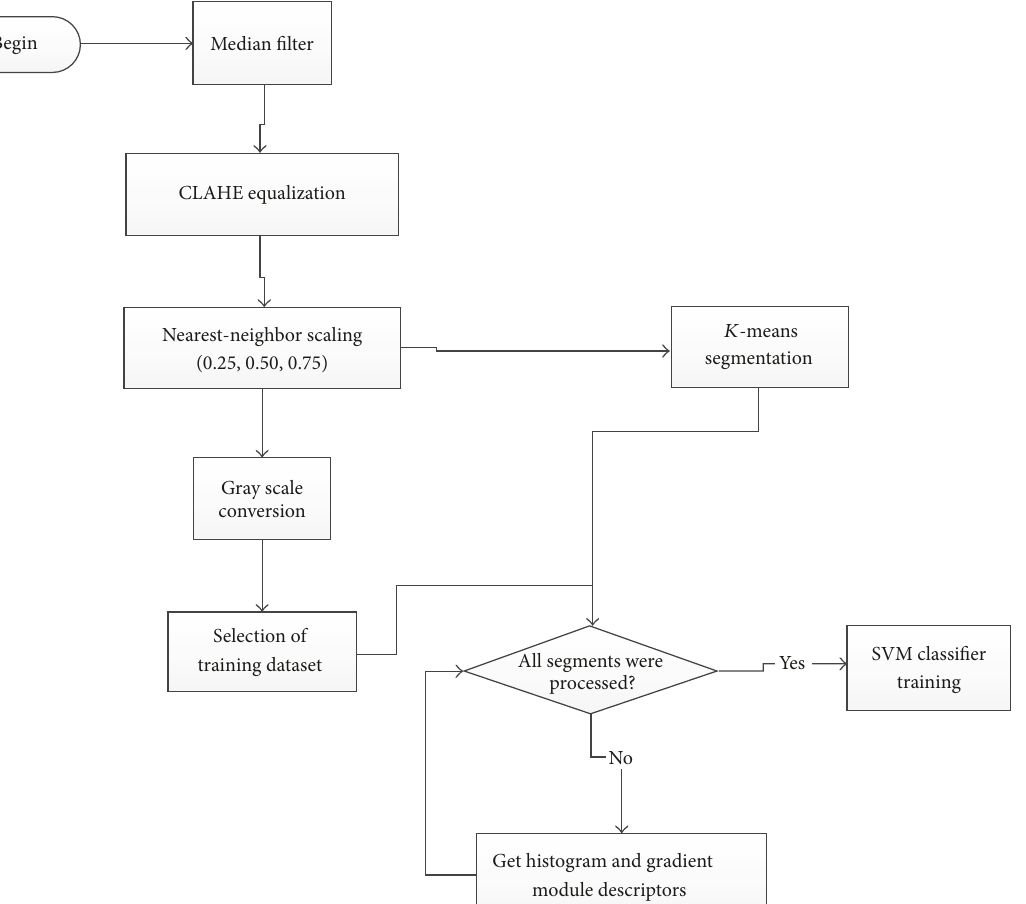
Figure 6: Lobesia botrana recognizer algorithm flow diagram.